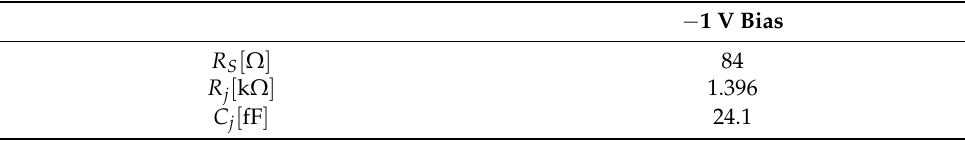
Table 1. Extracted parameters of components in equivalent